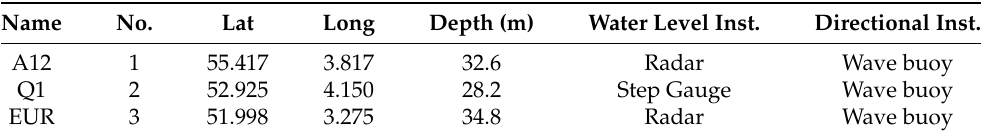
Figure 1. Bathymetry of the southern part of the North Sea basin. Locations of measuring stations given by black markers and numbers (see Table 1 for more information). The color bar corresponds to water depth in m with respect to mean sea level. Table 1. Station and instrument information. Radar: Saab L2. Step gauge: Marine 300. Wave buoy: